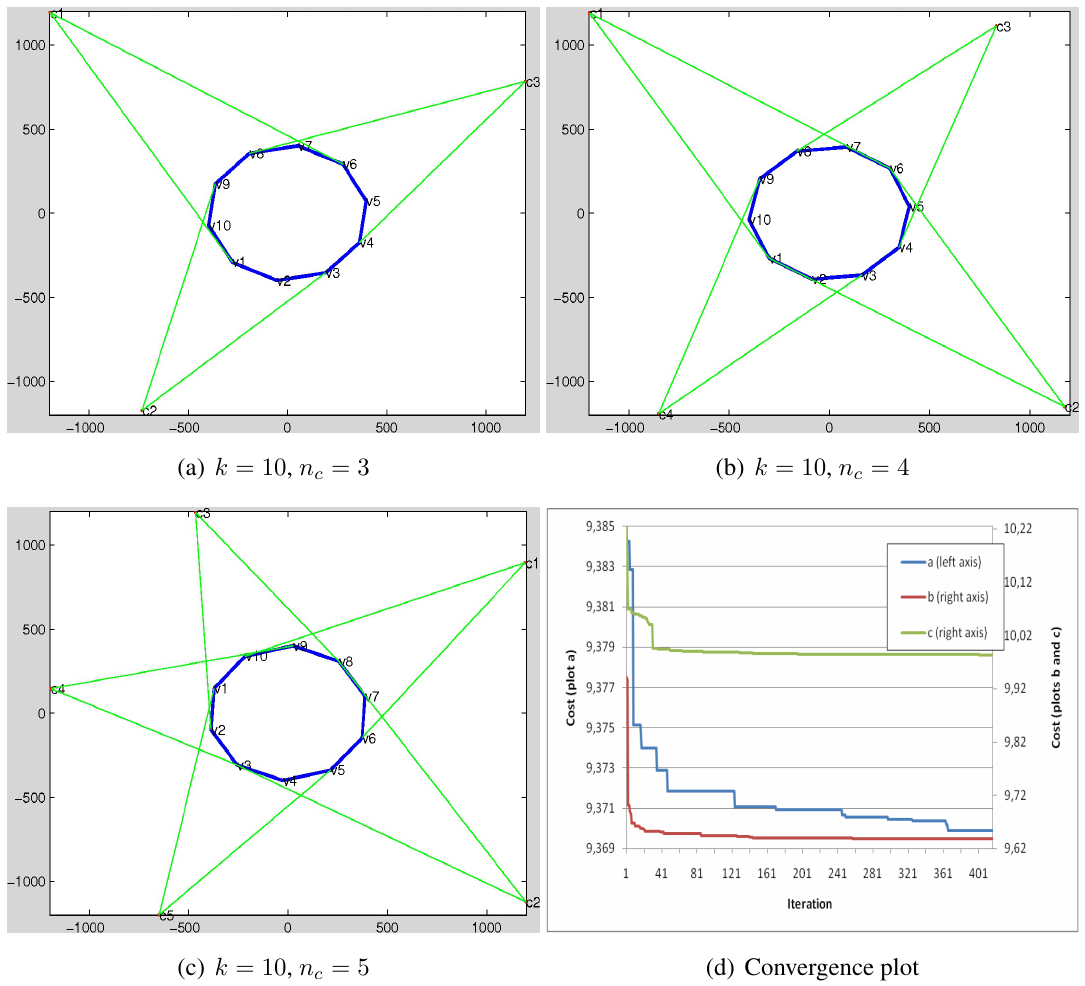
Figure 8. Results for camera placement optimization using the proposed GA. ( a – c ) depict three different samples. In each sample, a polygon with k vertices is randomly generated and the purpose of the algorithm is to search for an optimal coverage using n cameras. The convergences for the samples are plotted in ( d ). The vertical axis depicts the cost value for the fittest chromosome in each iteration, once it gets divided into the number of genes ( n ). The dimension of the search space is 1200 × 1200 cm 2 c